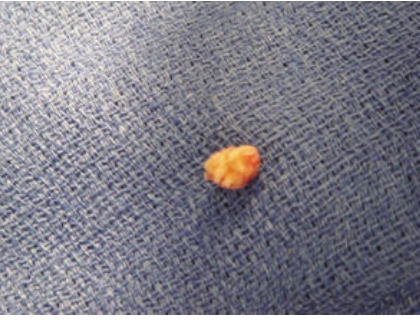
Figure 3: Histology